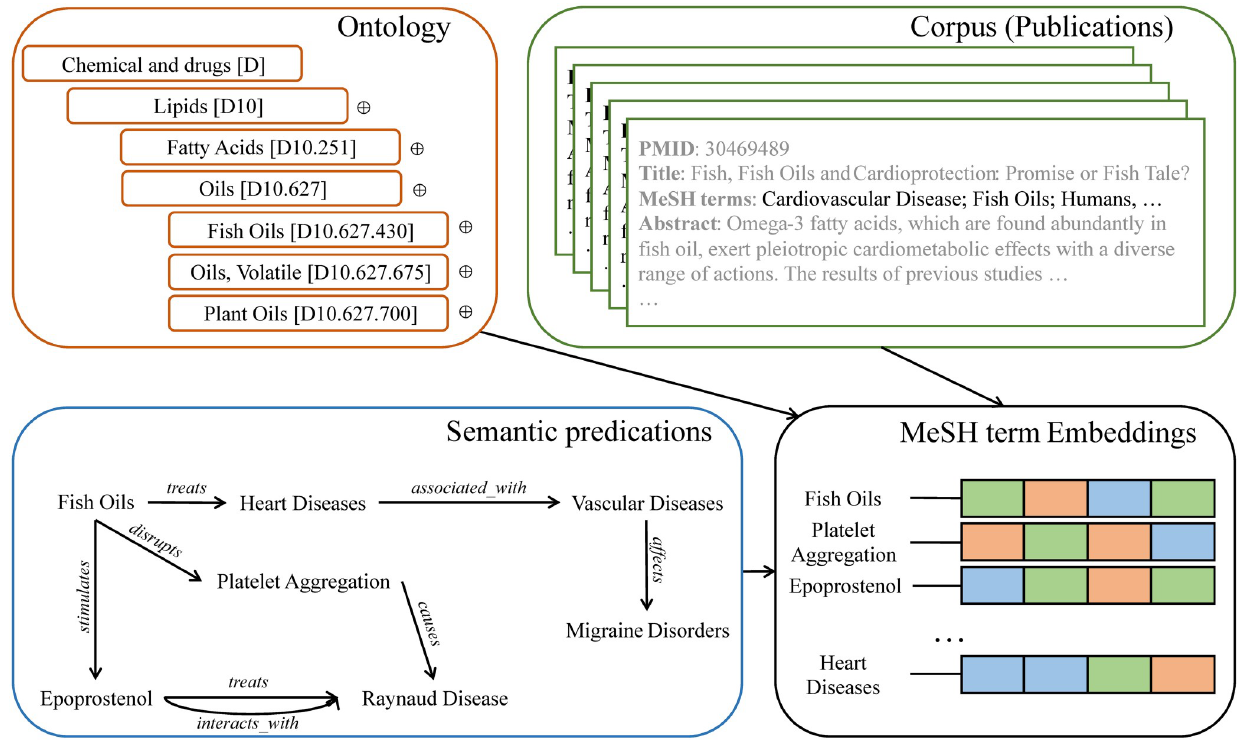
Fig 1. Problem definition. COS aims to learn MeSH term embeddings based on three data sources: corpus (the green block), ontology (the orange block), and semantic predications (the blue block). The structured relationships between MeSH terms are different across the data sources. The learned MeSH term embeddings should contain the information from all data sources.